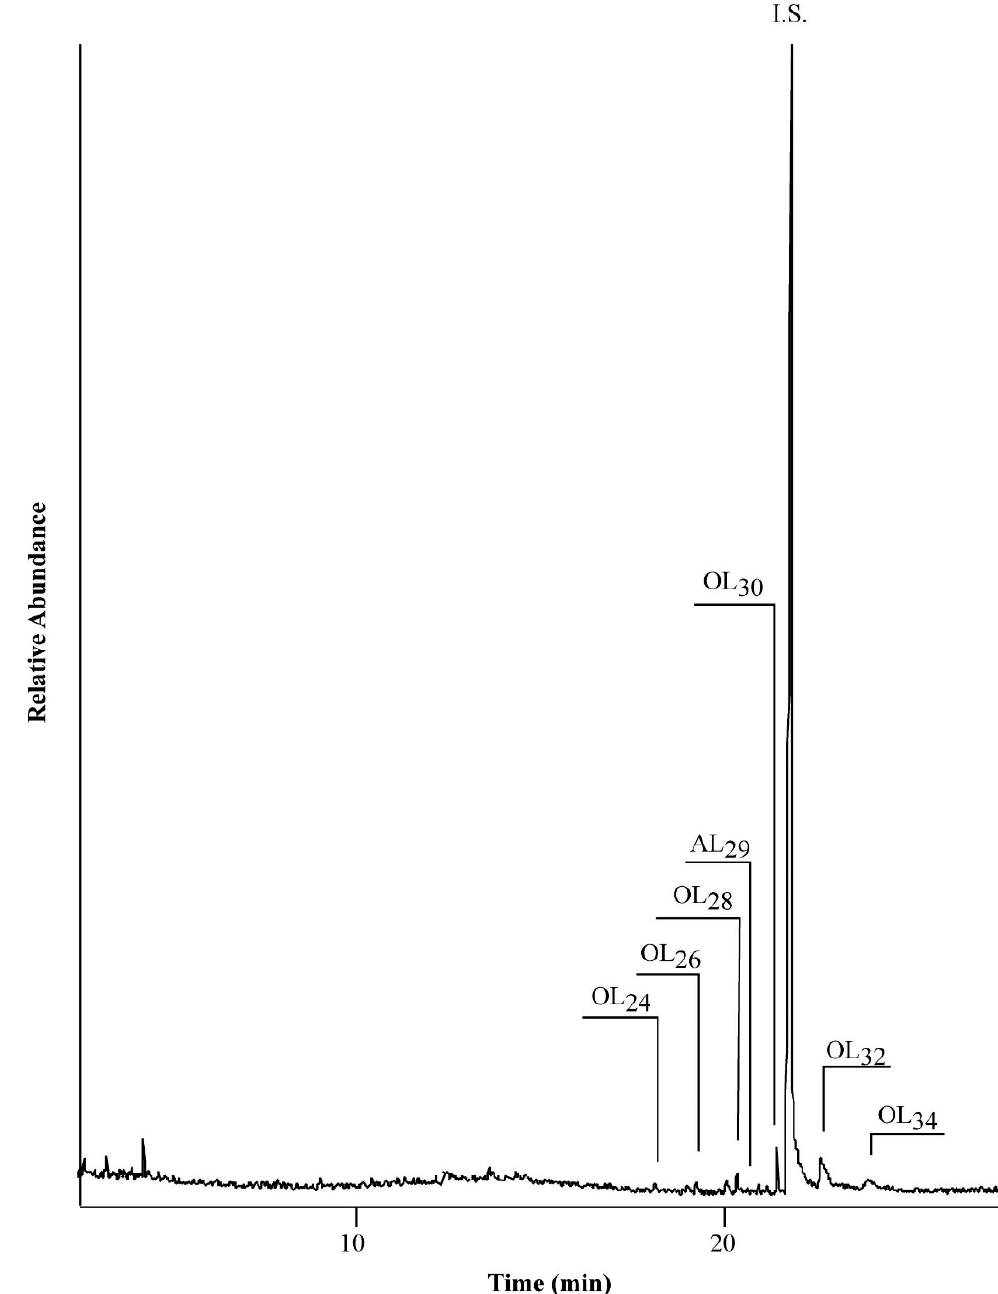
Figure 2. GC/MS of neutral fraction from chloroform/methanol extraction of sample 10. Note that the long-chain alkanol series is present, but in smaller amounts than the acidic methanol extraction, shown in Figure 3.